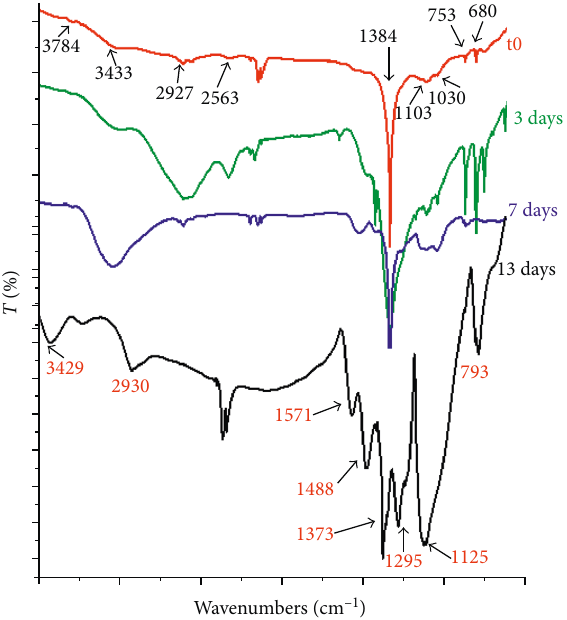
Figure 2: FTIR spectra of the nanocomposite during the poly- merization reaction.